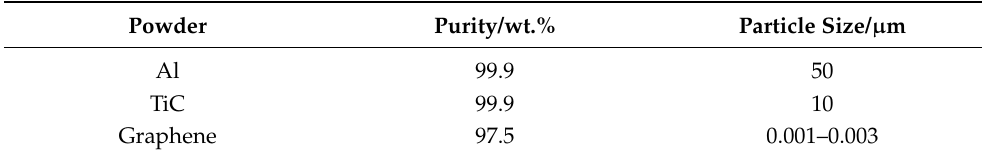
Table 1. Composition and granularity of raw